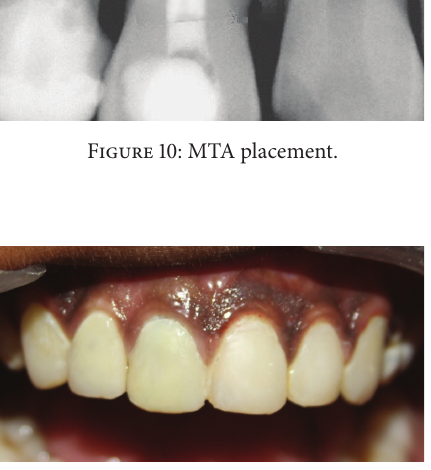
Figure 11: Direct and indirect composite restorations.